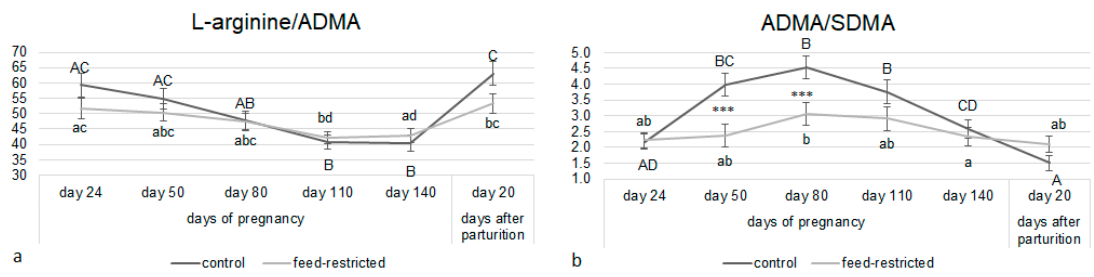
Figure 4. L-arginine/ADMA ( a ) and ADMA/symmetric dimethylarginine (SDMA) ratios ( b ) from day 24 of pregnancy to day 20 after parturition in control and feed-restricted ewes carrying single fetus, twins, and triplets. Asterisks indicate significant differences between control and feed-restricted ewes: ANCOVA *** p < 0.001. Different letters indicate significant differences within the same group: Upper-case letters for control group and lower-case letters for feed-restricted group.